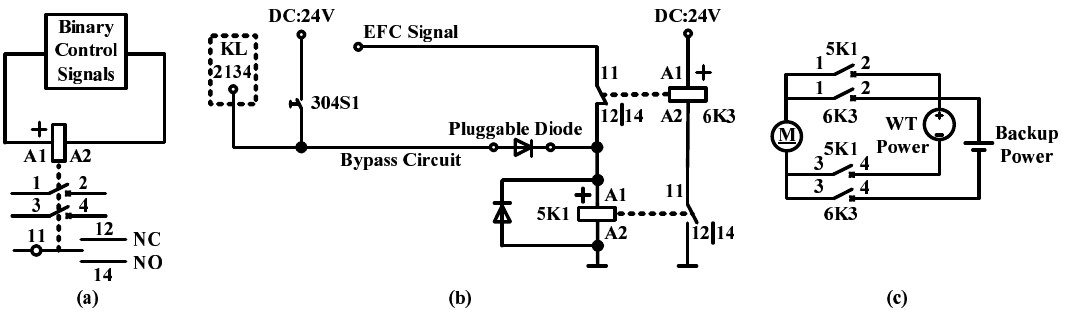
Figure 6. Control circuit for LVRT. ( a ) schematic diagram of DC contactor; ( b ) control circuit for LVRT; ( c ) power switching